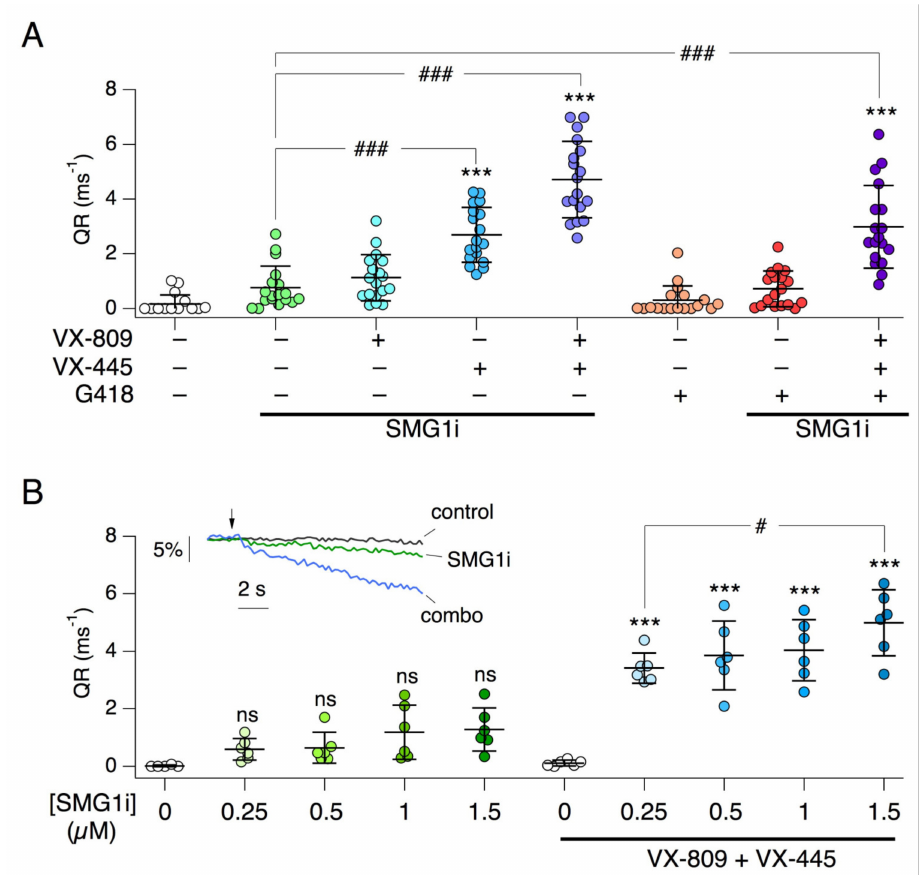
Figure 9. Functional analysis of W1282X-CFTR rescue with the HS-YFP assay. ( A ) Scatter dot plot reporting W1282X-CFTR activity (quenching rate, QR) in cells treated with the indicated combinations of compounds: SMG1i (1 µ M), VX-809 (1 µ M), VX-445 (5 µ M), G418 (0.5 mg/mL). ***, p < 0.001 vs. control. ###, p < 0.001 vs. SMG1i alone. ( B ) Dose–response relationship for SMG1i in the absence and in the presence of CFTR correctors. ***, p < 0.001 vs. no SMG1i. #, p < 0.05 between indicated conditions. The inset shows representative traces from the HS-YFP assay in which iodide-rich solution is added (arrow) to start fluorescence quenching caused by iodide influx through CFTR. Conditions were vehicle alone (control), 1 µ M SMG1i, and the combination of SMG1i plus VX-809 and VX-445